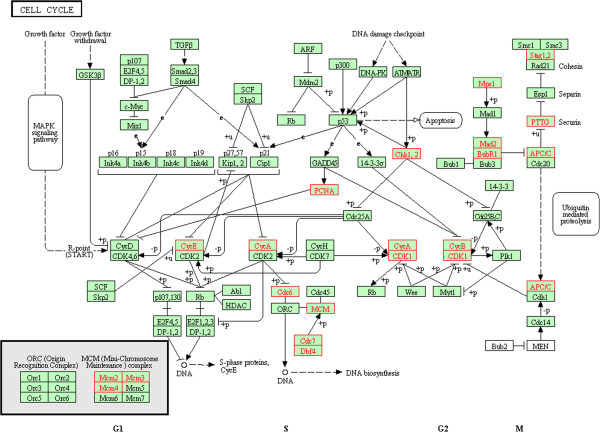
Cell cycle pathway. The red stars indicate the up-regulated genes of mesenchymal stem cells from primary osteoporosis tissues in this pathway.